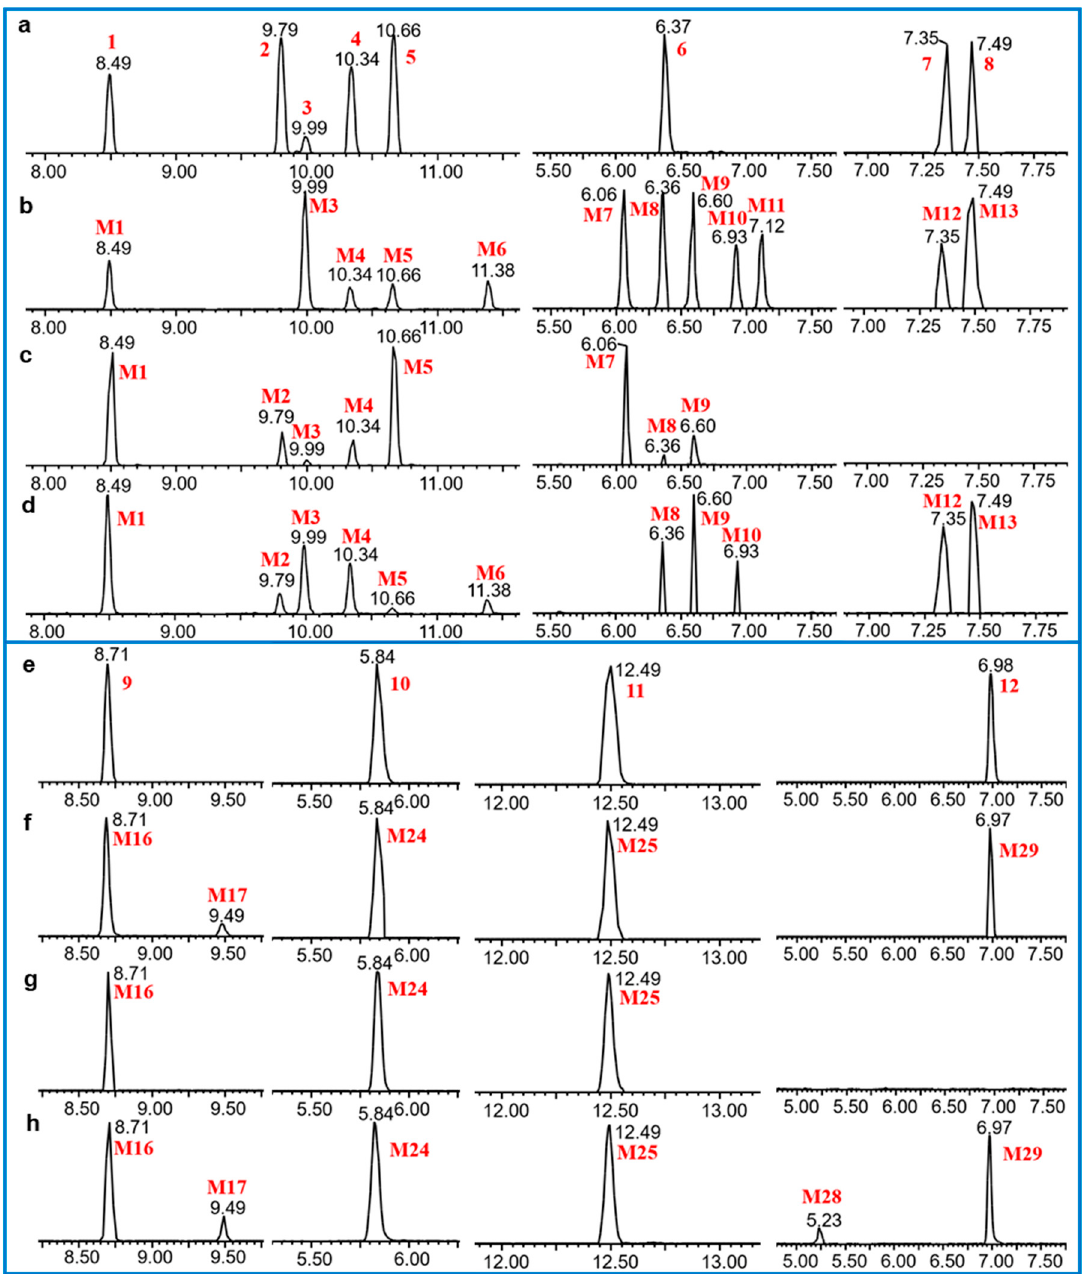
Figure 8. Extracted ion chromatograms of reference standard isolated from microbial transformation samples ( a , e ) and euphorbiasteroid metabolites in rat plasma ( b , f ), urine ( c , g ) and feces ( d , h ).